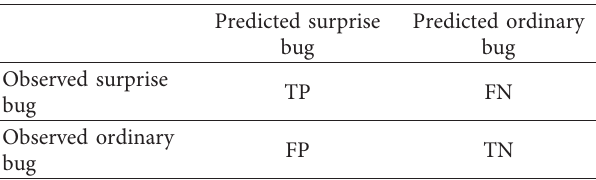
Table 3: The definitions of precision, recall, and F-Measure for surprise bugs.